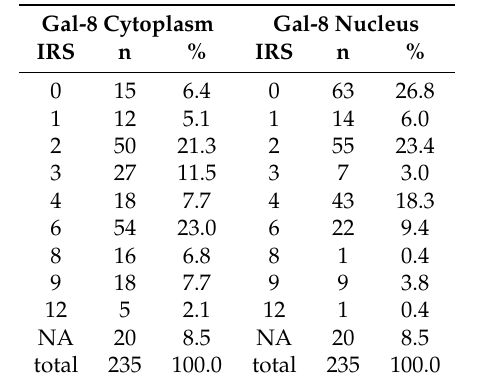
Table 2. Staining results of Gal-8 in the cytoplasm and the nucleus. Gal = galectin; NA = not applicable; IRS = immunoreactivity